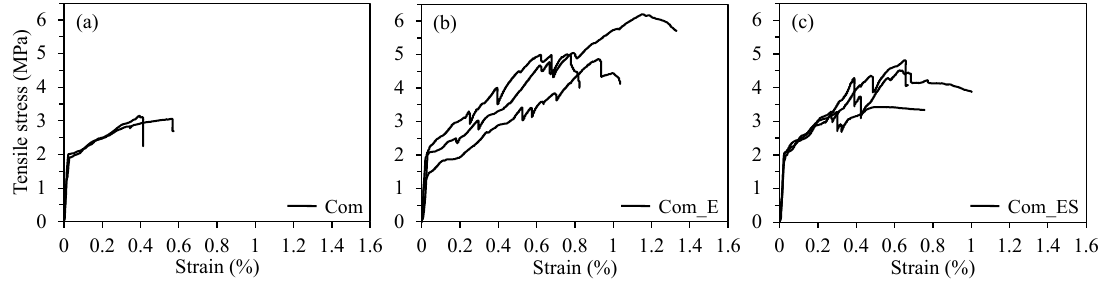
Figure 14. Tensile stress–strain relationship of TRM coupons under sound conditions: ( a ) coupons without surface treatment; ( b ) coupons impregnated by epoxy; ( c ) coupons coated with aluminum oxide powder after epoxy impregnation.